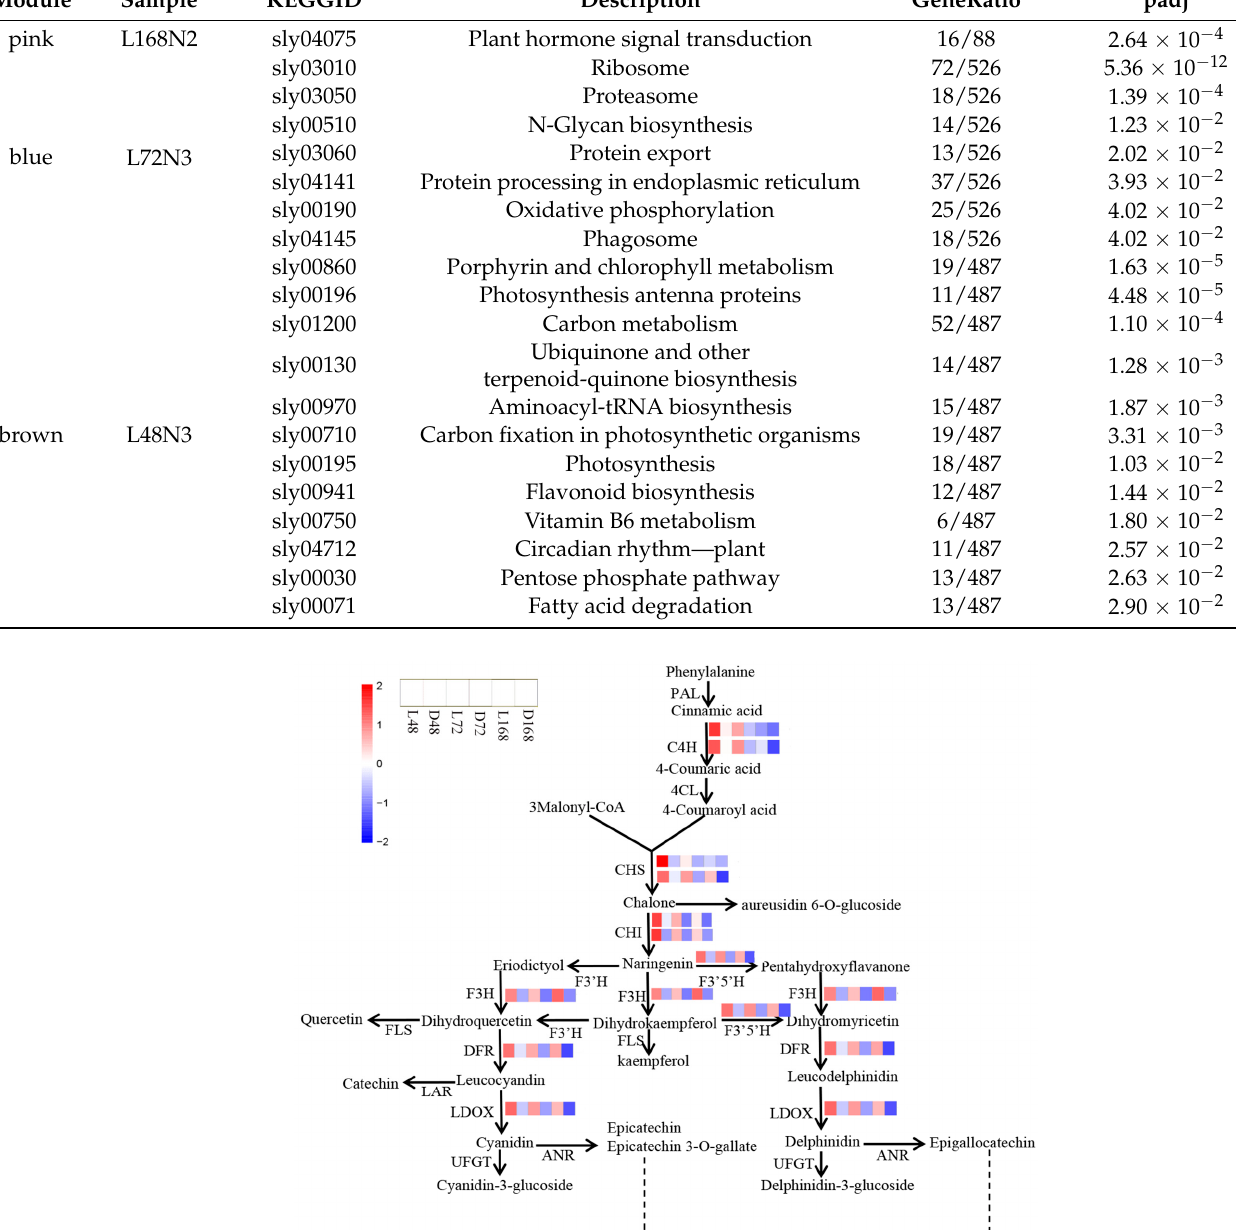
Table 3. KEGG analysis of sample-specific modules for different light treatments.